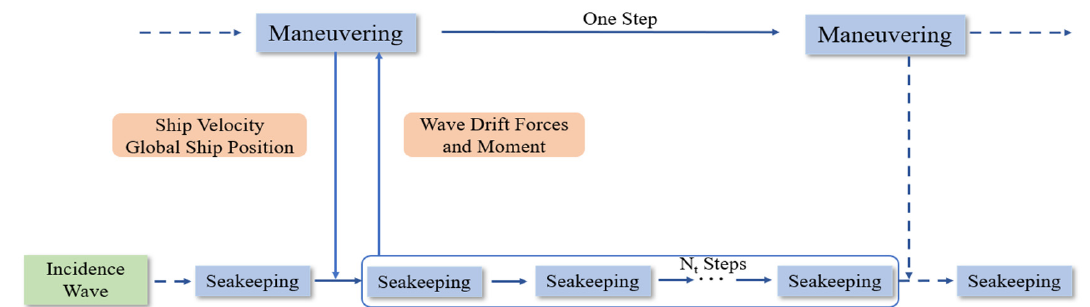
Figure 1. Two-time scale model of ship maneuvering and seakeeping coupling.